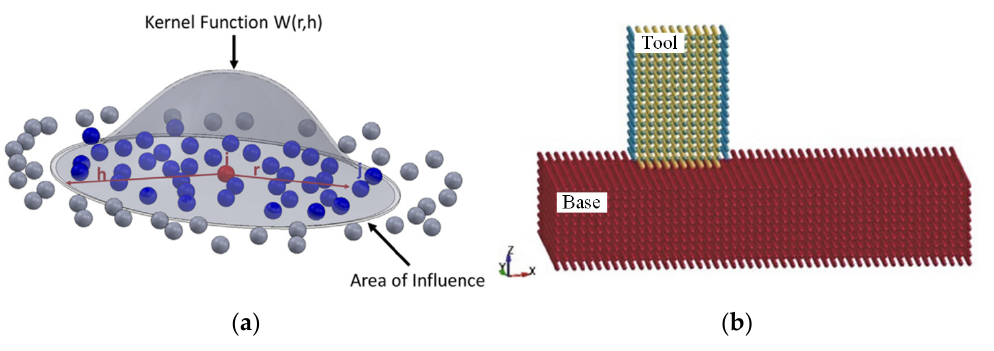
Figure 14. Different types of modeling approaches. ( a ) SPH of kernel function interpolation. ( b ) Model with SPH for all components.